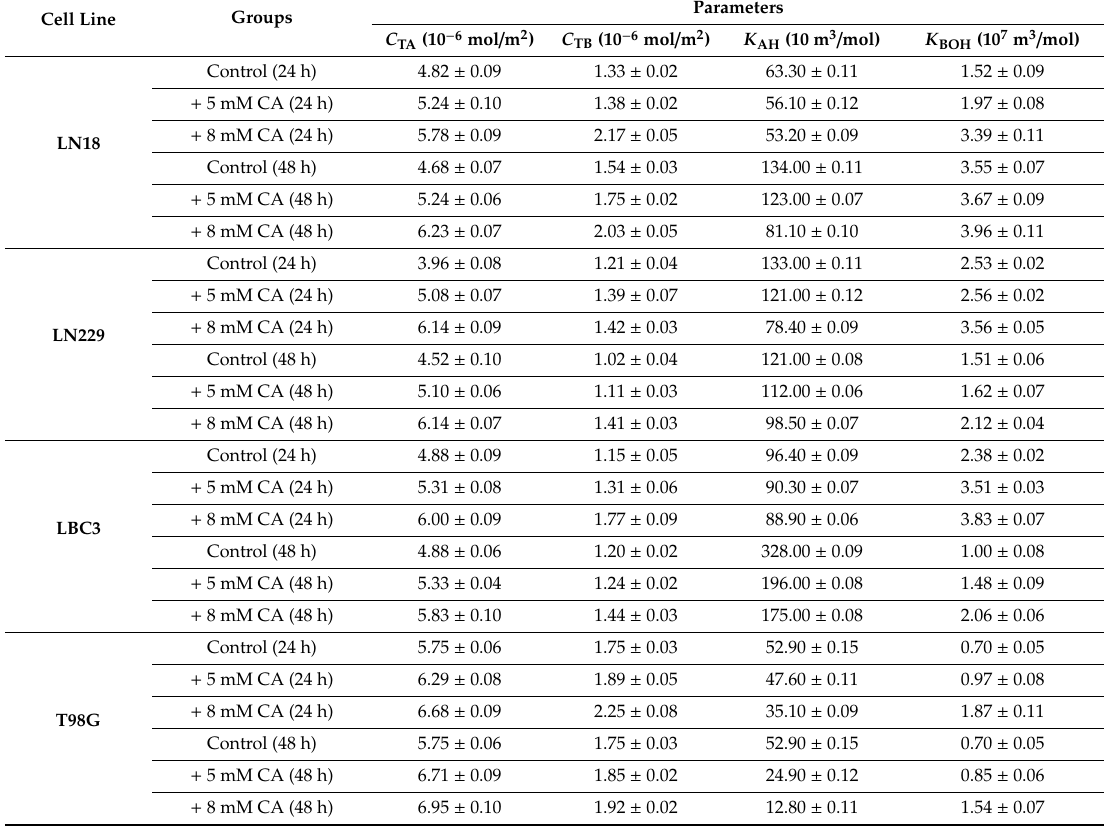
Table 1. E ff ect of p-coumaric acid on the acidic and basic functional groups concentrations and associations constants with H + and OH - ions of glioblastoma cell